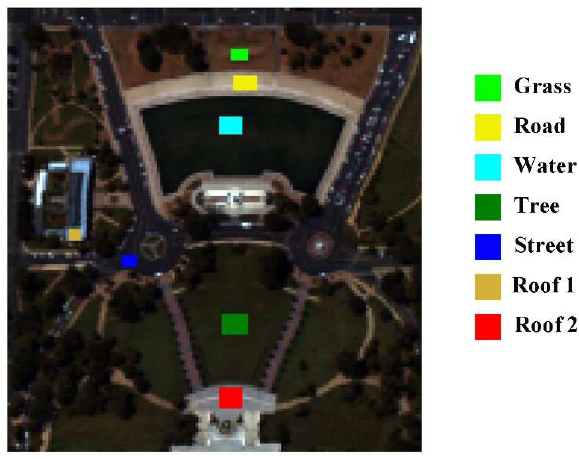
Figure 14. The true color image of Washington DC Mall. Table 4. Experimental results of Washington DC Mall